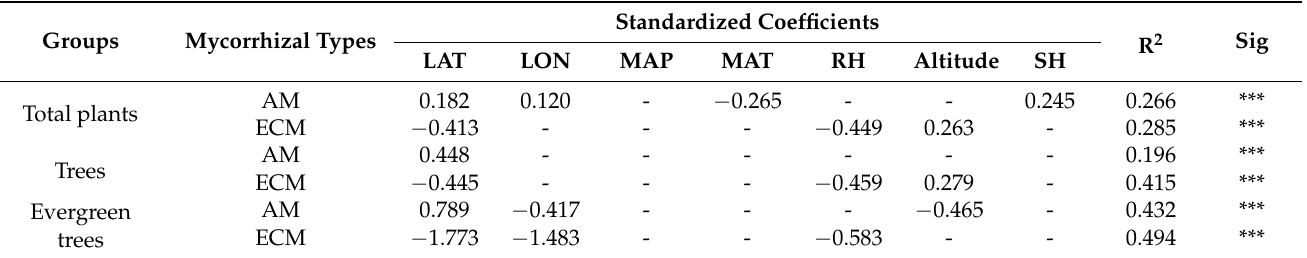
Table 1. Results of the multiple regression analyses for predicting the leaf δ 13 C of AM and ECM plants with the combination of all